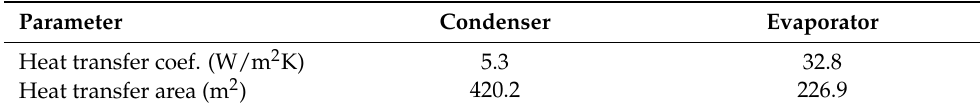
Table 4. Characteristics of evaporator and condenser.